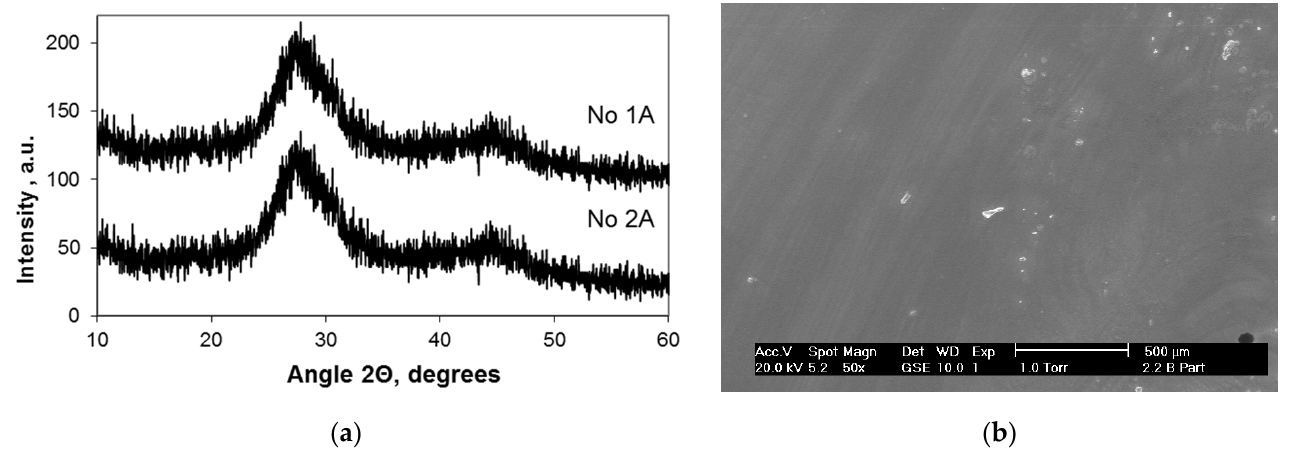
Figure 1. XRD patterns ( a ) and SEM micrograph ( b ) of the materials 1A and 2A ( b ).